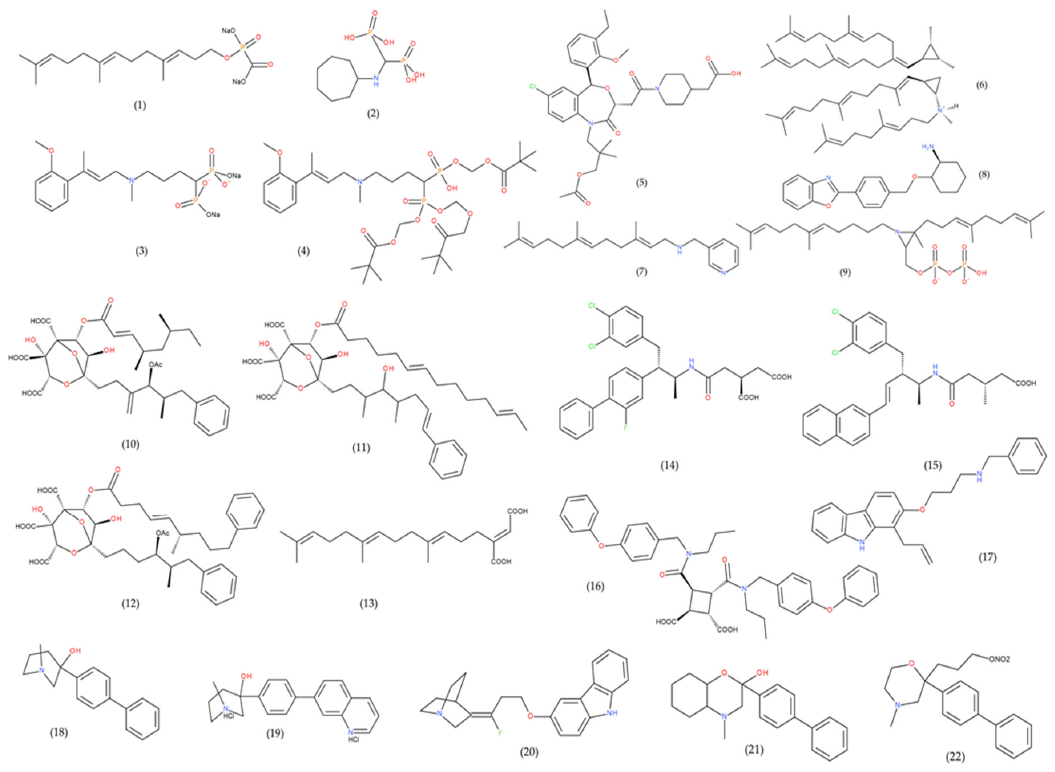
Figure 6. FDFT1 inhibitors. The names of the compounds corresponding to each number are shown in Table